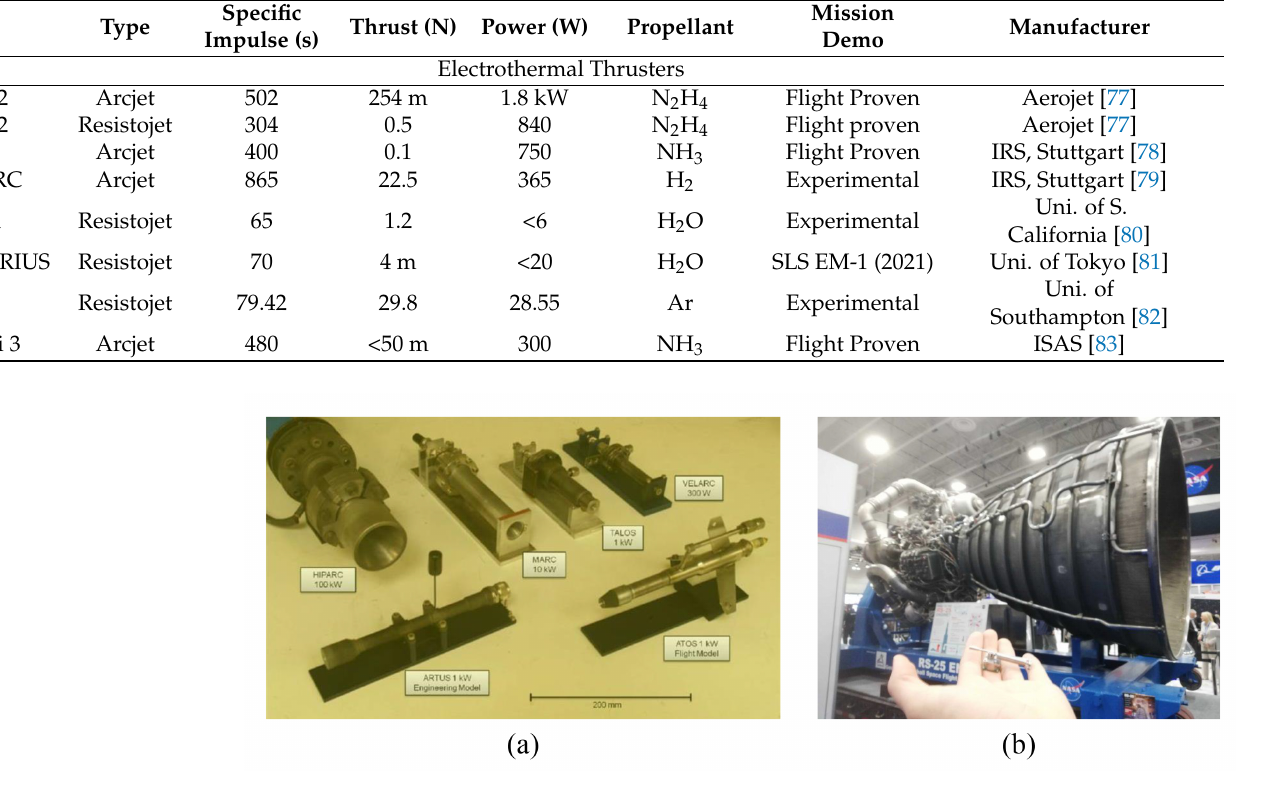
Figure 7. Electrothermal thruster examples: ( a ) Arcjet thruster range at IRS (upper line from left: